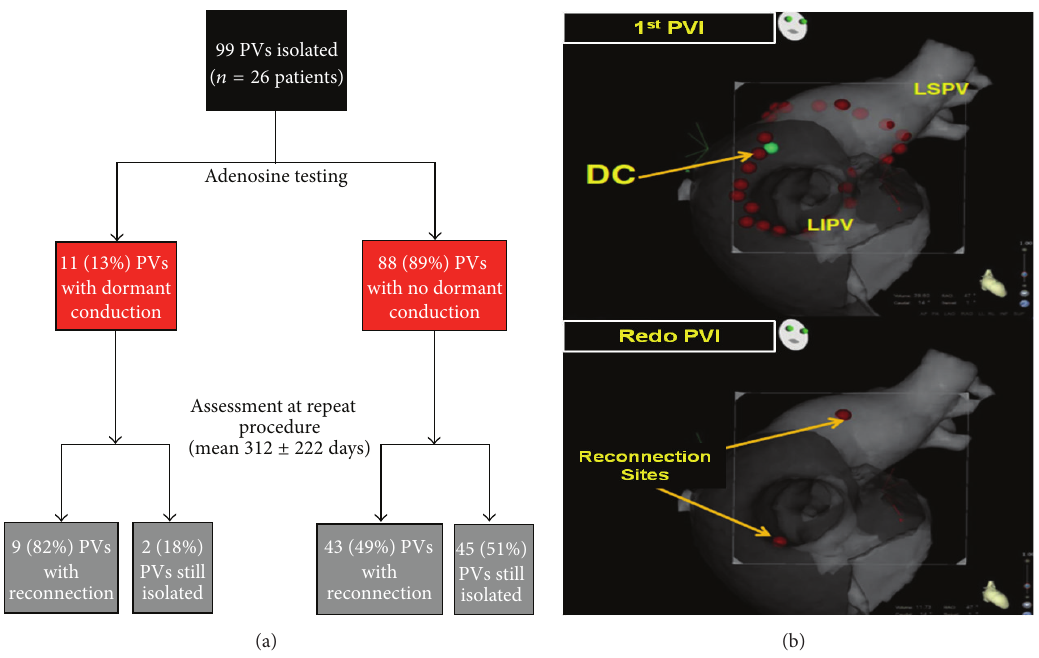
Figure 6: (a) Adenosine testing results and PV reconnection rate at redo procedure in Lin et al. [34]. (b) Example of redo procedure reconnection sites that totally differed from DC sites at first procedure [35]. DC: dormant conduction. PVI: pulmonary vein isolation (see text for